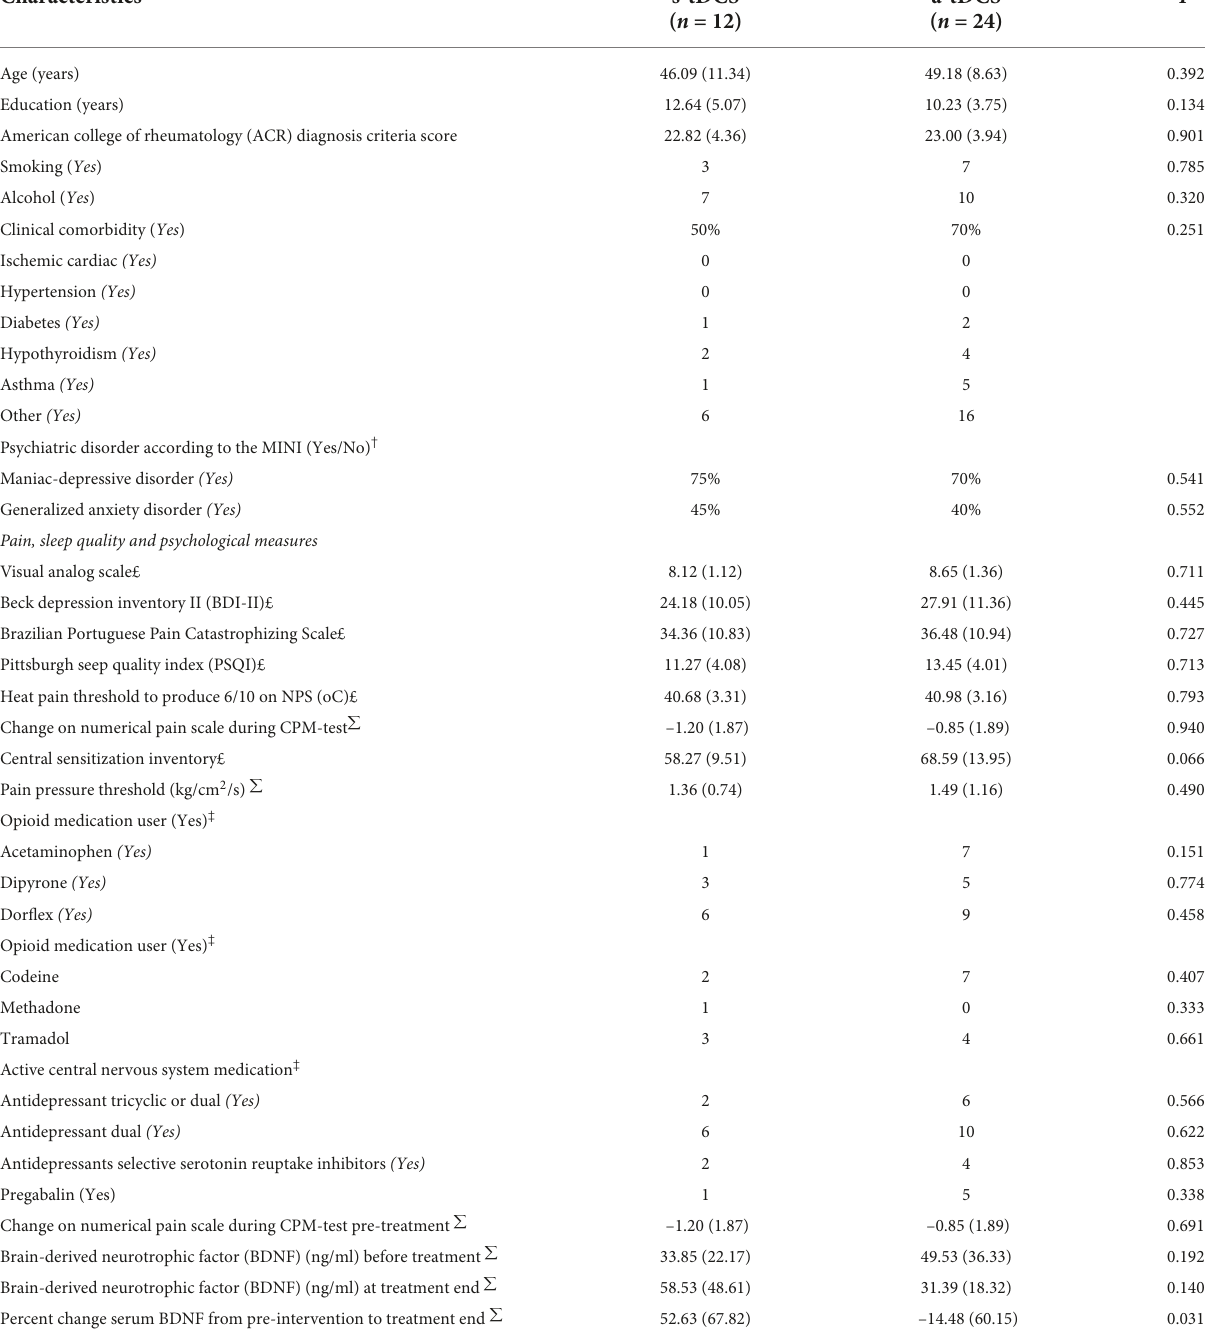
TABLE 1 Epidemiological and clinical characteristics at baseline, according to the treatment group, values are given as the mean (SD) or frequency ( n = 36).